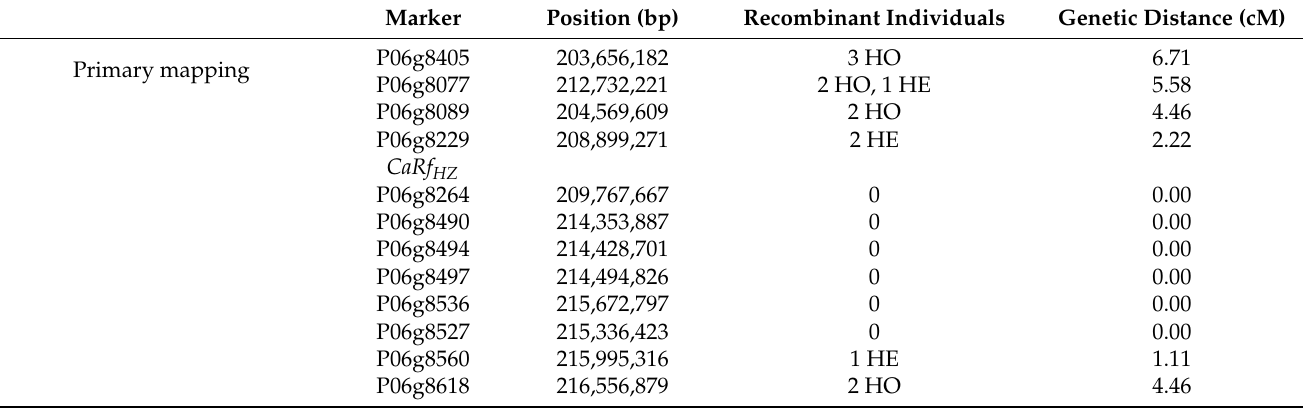
Table 3. The recombinant number and genetic distance between the CaRf HZ gene and its linked